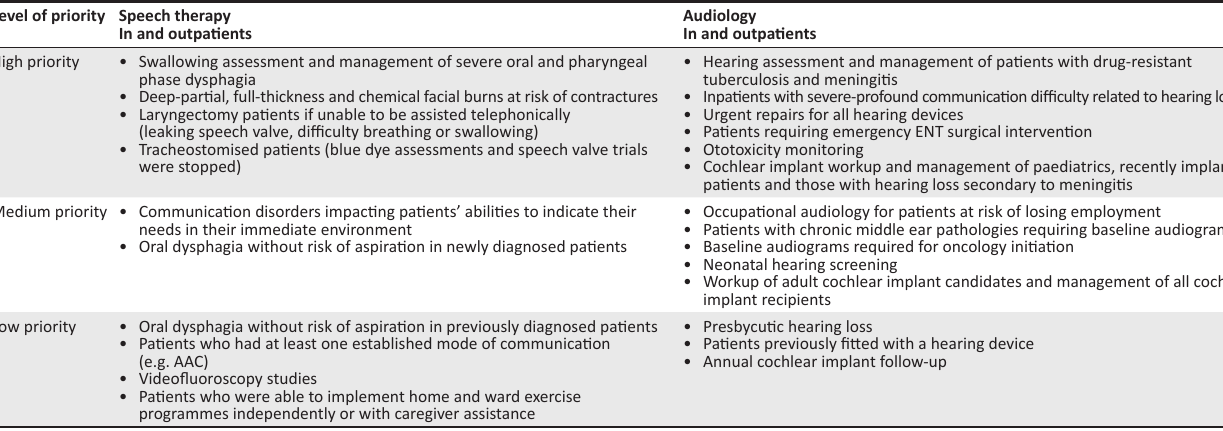
TABLE 4: Initial prioritisation